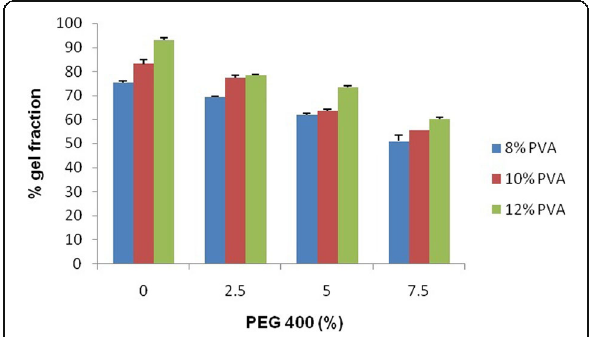
Fig. 3 Effect of concentration of PEG 400 and PVA on percentage gel fraction of the hydrogel sheets, n = 3, mean ± SEM